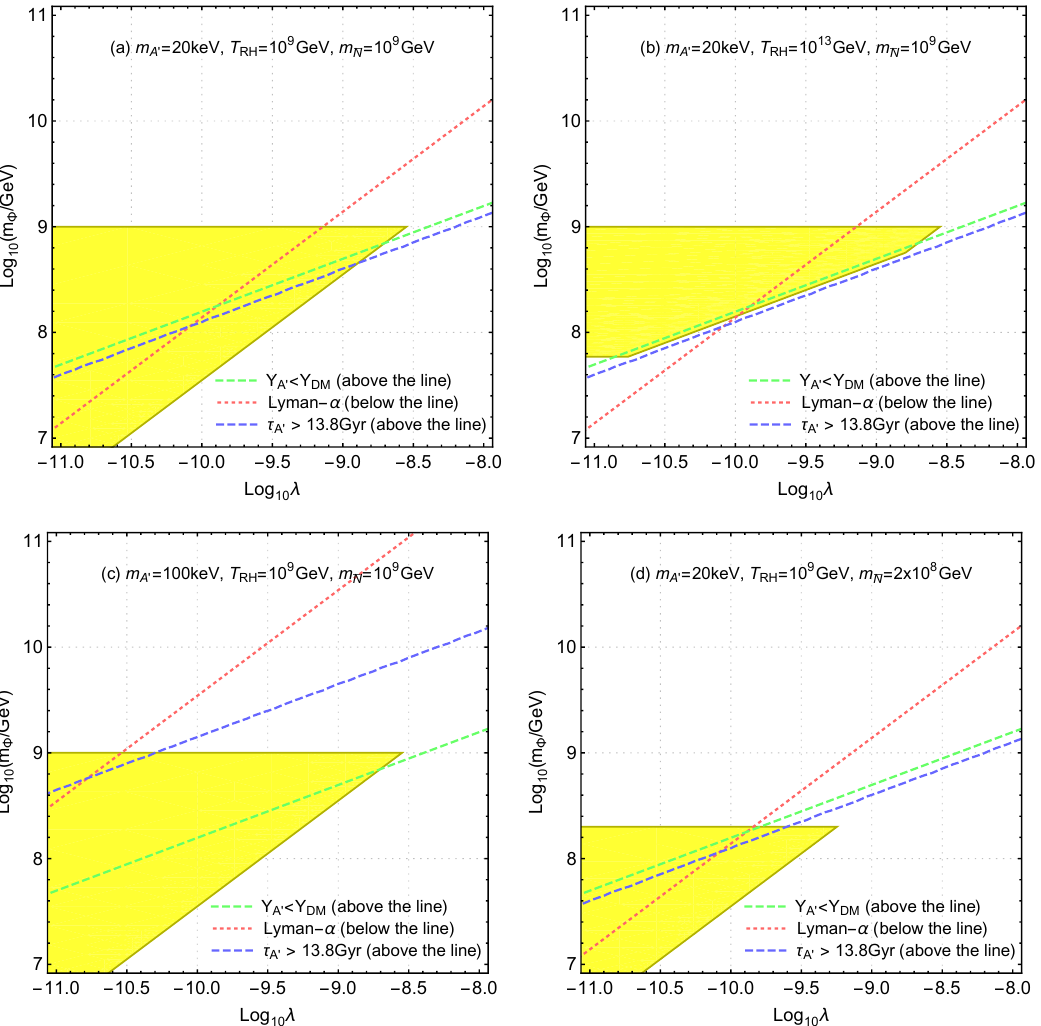
Figure 3 . The constraints on the parameter space of ( λ, m φ ) which is consistent with the conditions (1a), (2a), (3a 00 ) and (1c) presented in eq. (2.2), eq. (2.3), eq. (4.8), eq. (4.1) (yellow shaded region), τ A 0 & 13 . 8Gyr (the region above the blue dashed line) and Lyman- α forest constraint on m A 0 (the region below the red dotted line). Along the green dashed line, A 0 alone can explain the current µ DM abundance. The values shown in (a) being fiducial, each plot of (b), (c) and (d) results from variation of one of ( m A 0 , T RH , m ¯ N